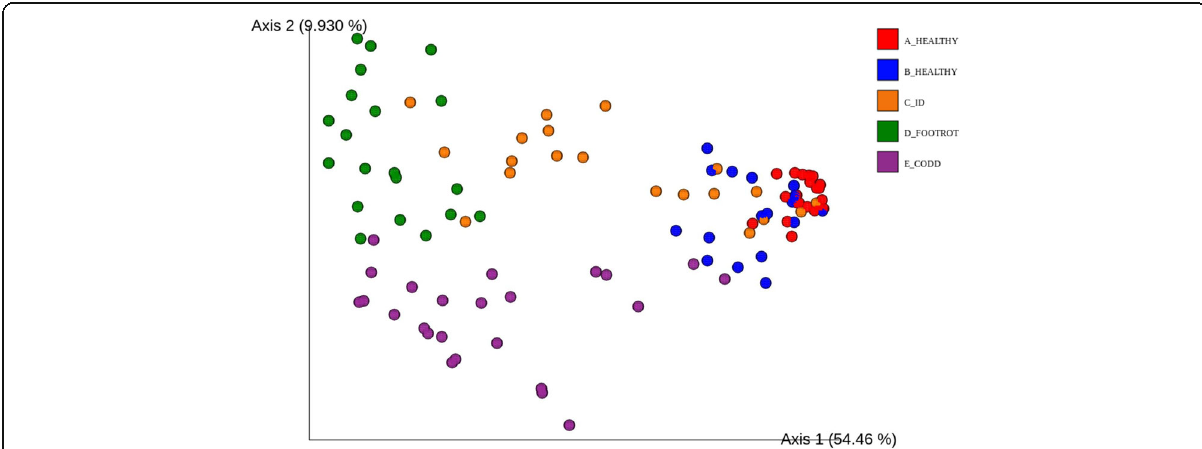
Fig. 3 Principle Coordinate Analysis (PCoA) plot showing differences in weighted UniFrac distances at different stages of CODD lesion development. ANOSIM for disease state overall (ANOSIM R statistic =0.64329, p = 0.001). Pairwise ANOSIM tests between microbiota at each phenotypic lesion stage (A_Healthy, B_Healthy, C_ID, D_Footrot, E_CODD) ( p =